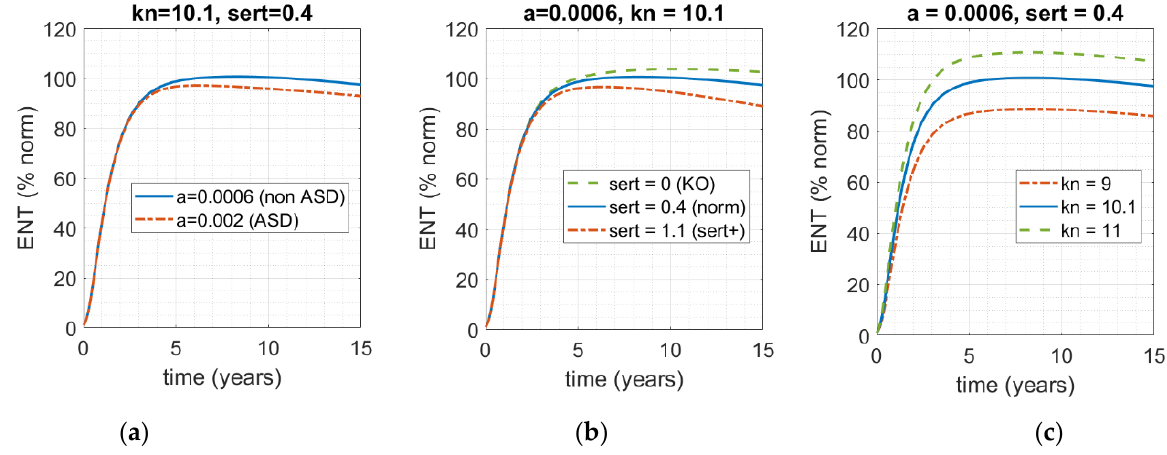
sert = 0.4; a = 0.0006); dot-dashed red and dashed green lines represent the impact of deviation of the norm. ( a ) The rate of serotonin clearance ( sert = 0.4) and rate ENS growth as a function of serotonin concentration ( k n = 10.1) are fixed; rate of serotonin production over time a is varied. ( b ) Rate of serotonin production over time (parameter a ) and serotonin-mediated ENS growth ( k n ) are fixed; rate of SERT-mediated serotonin clearance from the gut is varied. ( c ) Varying rate of serotonin-me- diated ENS growth ( k n ), while keeping the other two factors fixed.